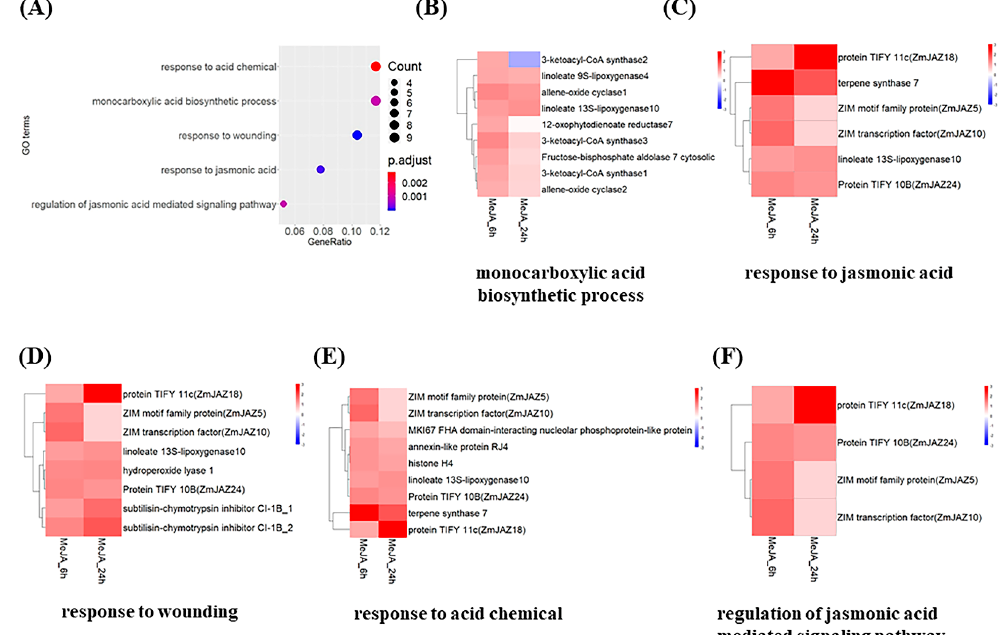
Figure 2. GO enrichment and clustering heat maps on the DEGs detected in MeJA treated stems. ( A ) GO enrichment of all DEGs detected. The color of the dot shows p -value of each cluster, and the size of the dot indicates the number of genes enriched. ( B – F ) clustering and heatmaps of differentially enriched clusters. The DEGs was selected with a criteria at adjusted p -value ( p.adj ) < 0.05 and log2Foldchange > 1 for upregulated genes, while log2Foldchange < − 1 for downregulated genes, relative to control. The bar on the side indicates the fold change of corresponding genes over that at 0 h shown on the